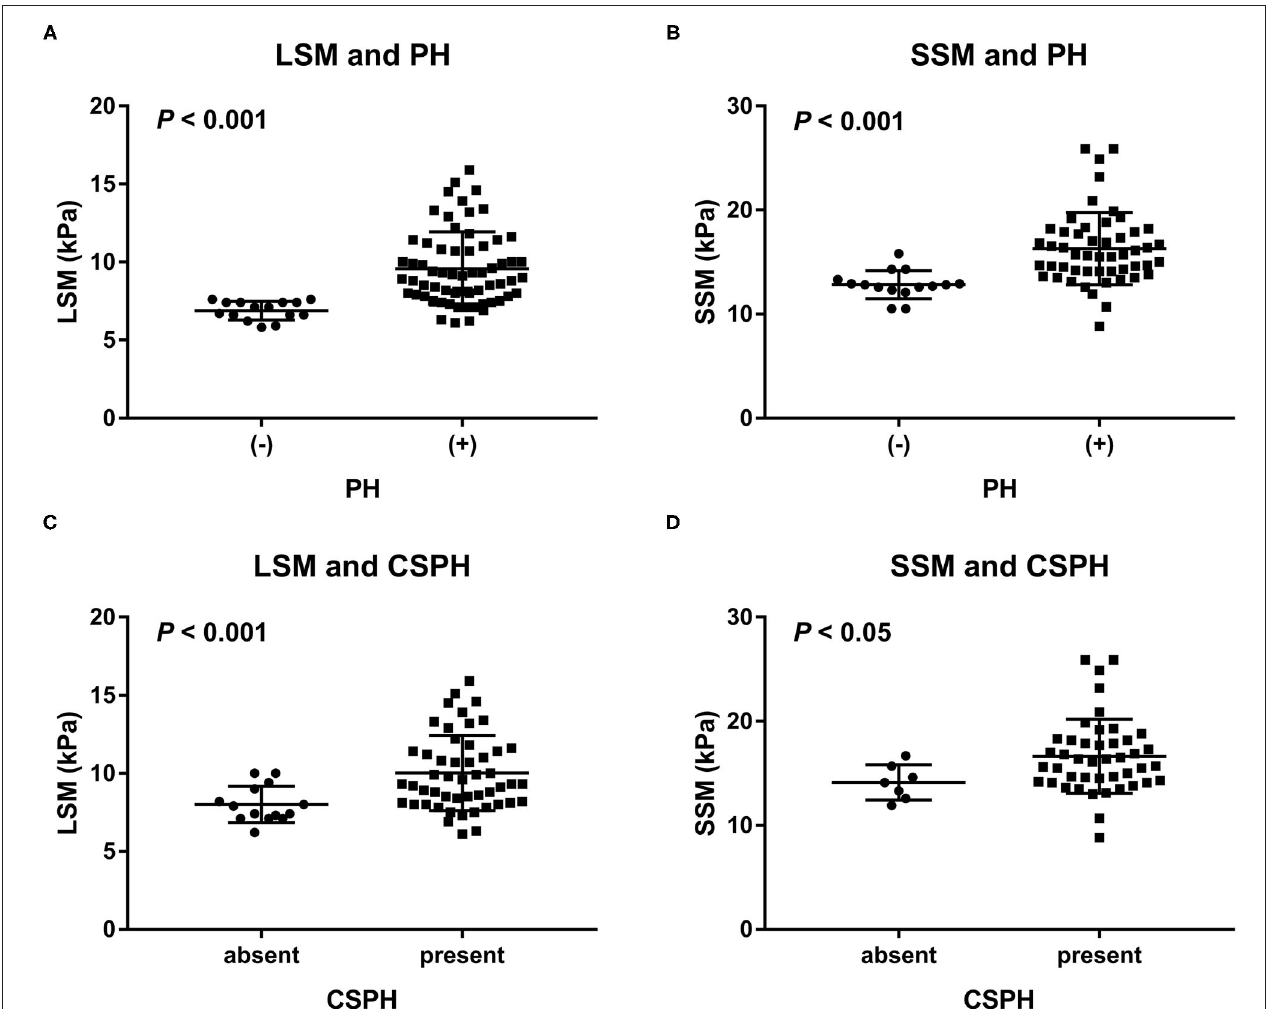
FIGURE 3 | Distribution of (A) LSM and (B) SSM in rats with and those without PH, as well as distribution of (C) LSM and (D) SSM in NAFLD rats with and those without CSPH (a portal venous pressure of 10 mmHg or higher). LSM and SSM were significantly higher in the rats with PH than in the rats without PH. Similarly, LSM and SSM were significantly higher in the rats with NAFLD and CSPH than in those with NAFLD but without CSPH. CSPH, clinically significant portal hypertension; LSM, liver stiffness measurement; PH, portal hypertension; SSM, spleen stiffness